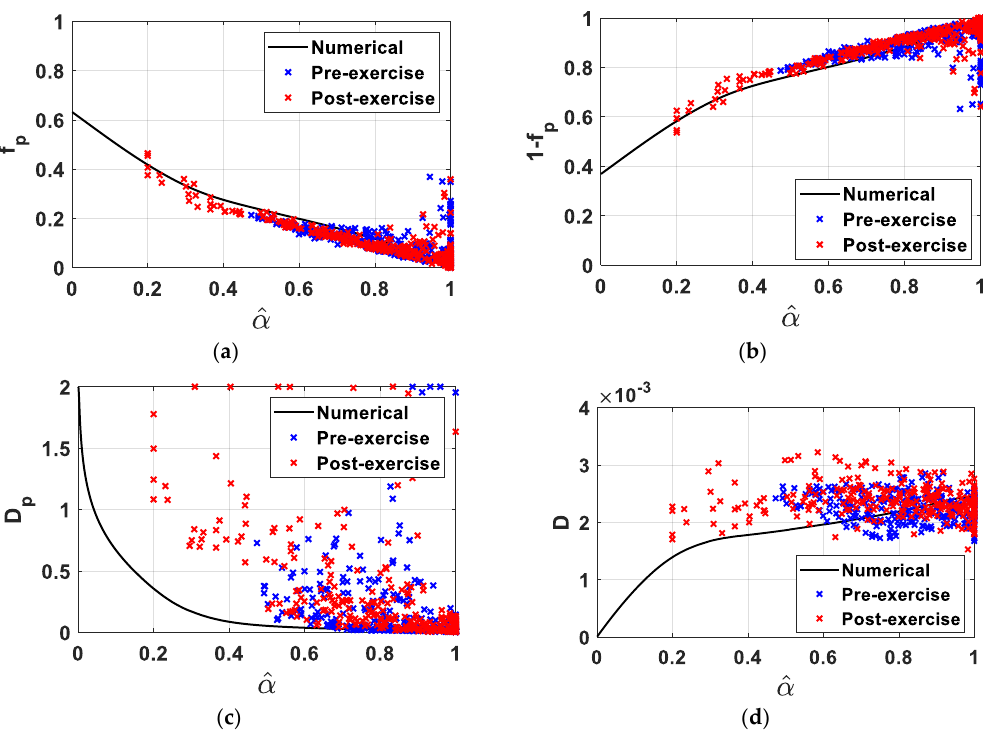
Figure 8. Experimental traces of biexponential model parameters obtained from ROI in the vastus lateralis at baseline and post-exercise, superimposed by numerical traces. Both numerical and experimental analysis used: 𝑏 = 0, 3, 7, 10, 15, 20, 25, 30, 40, 50, 70, 100, 200, and 400 s/mm 2 .